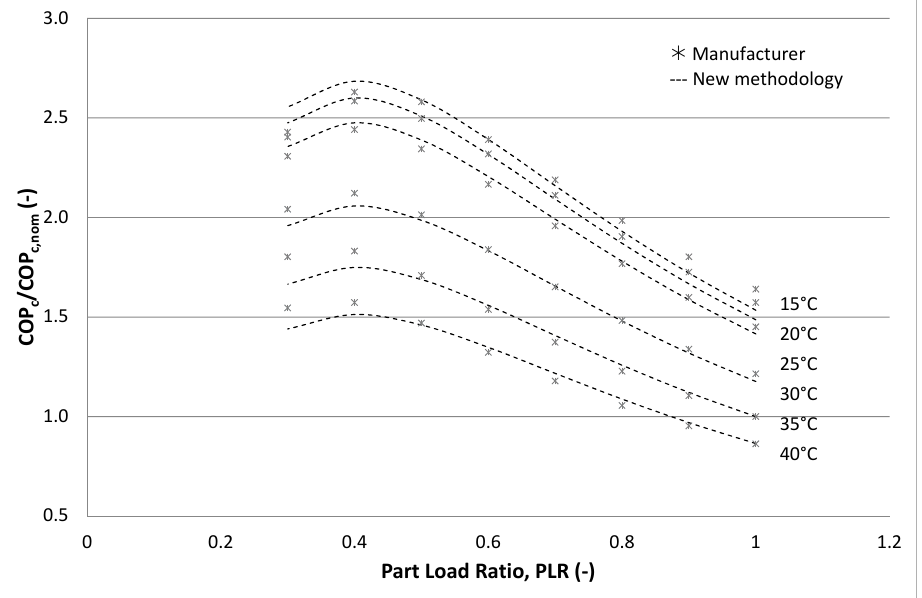
Figure 2. Variation of the cooling COP ratio as a function of part load ratio and outdoor dry-bulb temperature (manufacturer and EnergyPlus new model curves).